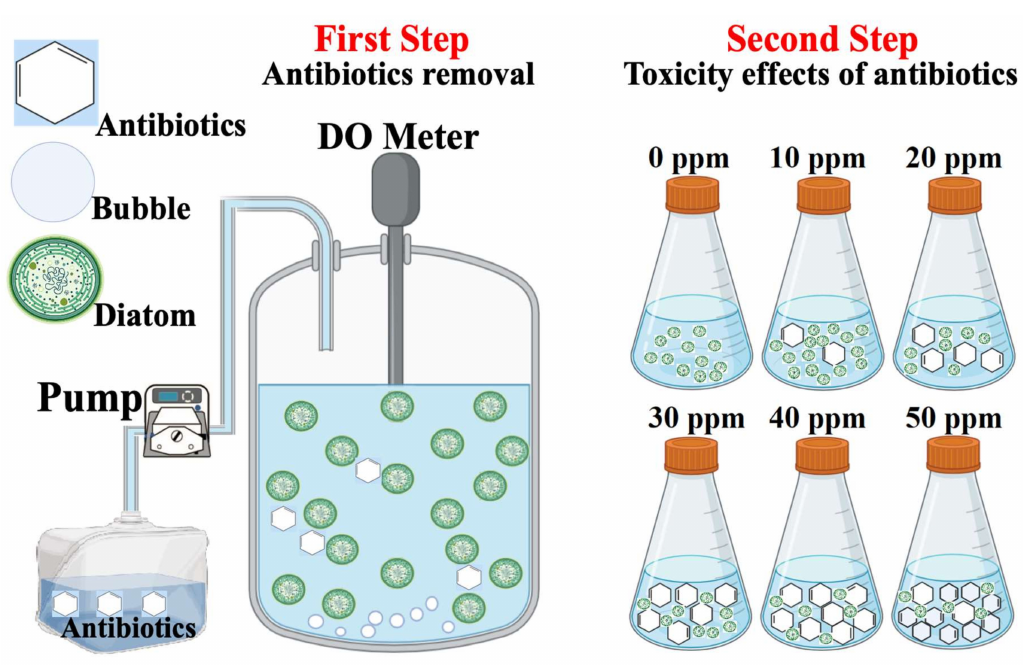
Figure 1. Schematics of the